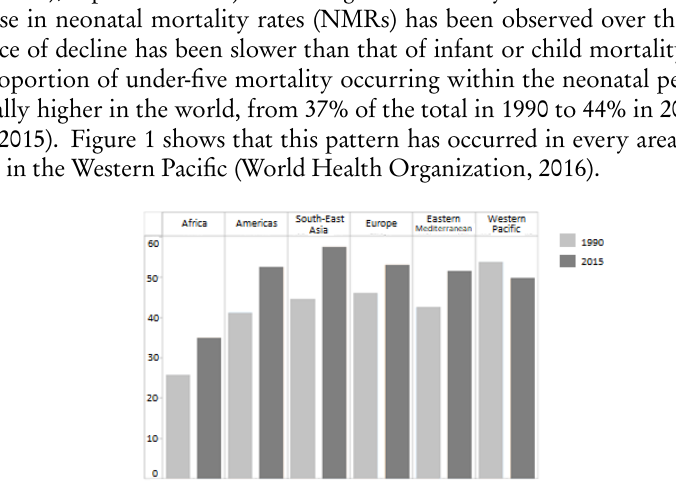
Figure 1 – Neonatal deaths as percentage of under-five mortality. According to UNICEF (2018) data, West and Central African countries